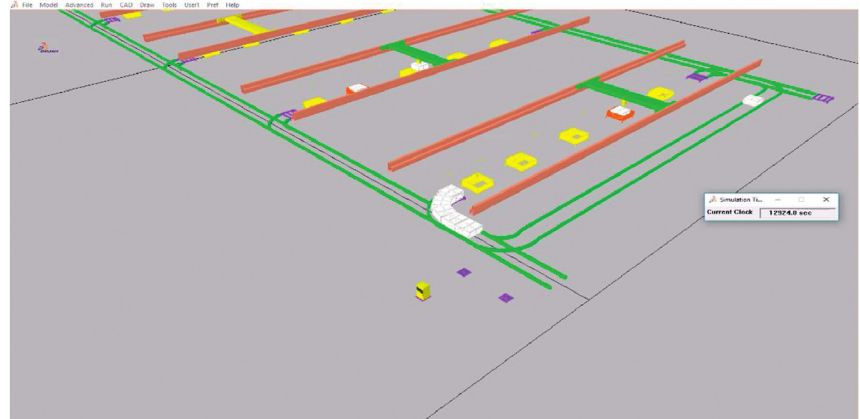
Figure 5: Simulation model’s production process.